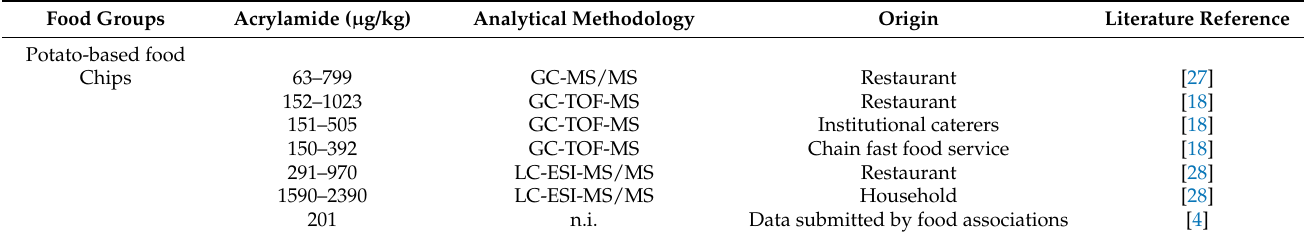
Results represent the mean (n = 15), standard deviation (SD), median, 90th percentile (P90), minimum and maximum levels. LOQ: limit of quantification (15 µ g/kg). Values below the LOQ were set at half the LOQ (7.5 µ g/kg). Different letters mean significant differences between the food groups ( p < 0.05). Table 2. Acrylamide concentration ( µ g/kg) reported by different international studies for the food groups analysed in the present